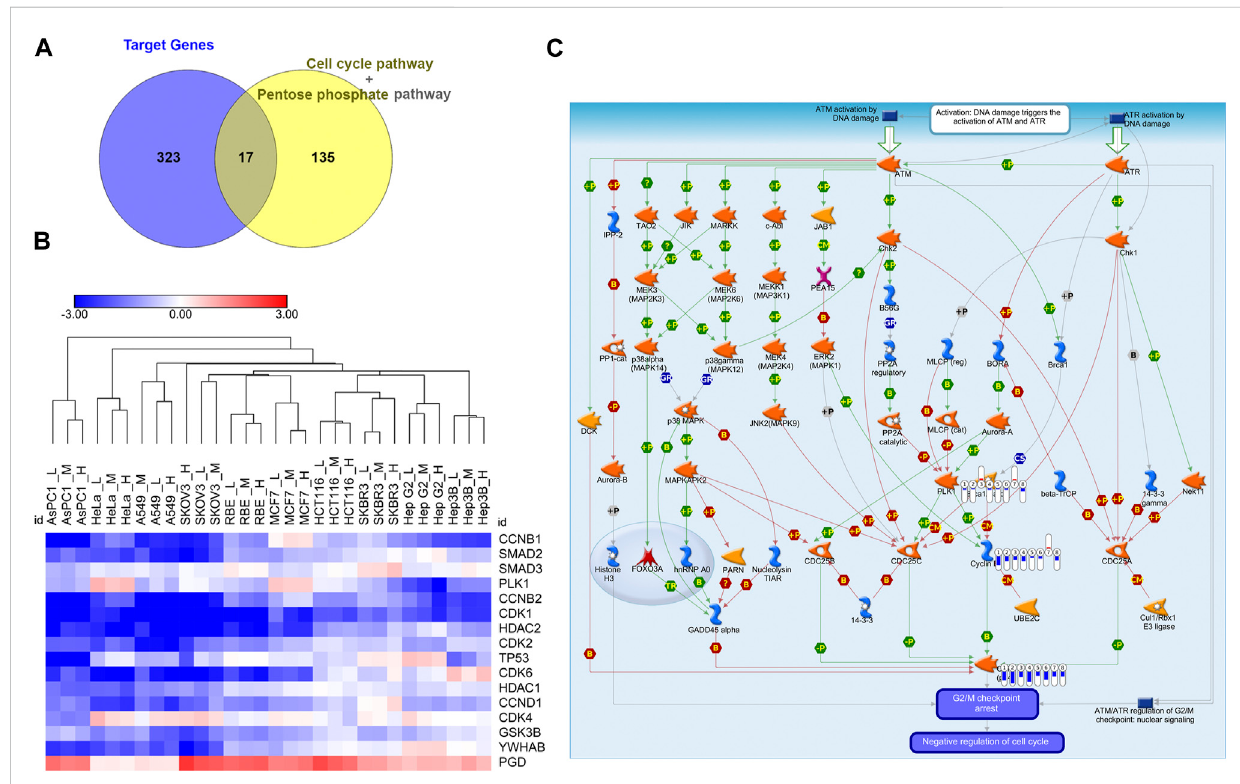
FIGURE 5 Identi fi cation of G2/M cell cycle arrest as the hub targeted pathway by CR. (A) The intersection of the Cell cycle and Pentose phosphate pathways- related genes with CR targets genes. (B) Log2 fold change heatmap of 16 genes among CR-treated cancer cell lines. Blue, downregulated; Red, upregulated. (C) PLK1,CDK1,andCCNBenrichedintheDNAdamage_ATM/ATRregulationofG2/McheckpointusingMetacore( p =1.056*10 − 6 ).Redand upwardthermometersindicateupregulatedgenesinthecorrespondingcellline;Blueanddownwardthermometersindicatedownregulatedgenes in the corresponding cell line. The thermometer level was the mean log2 fold changes of CR treatment groups in each cell